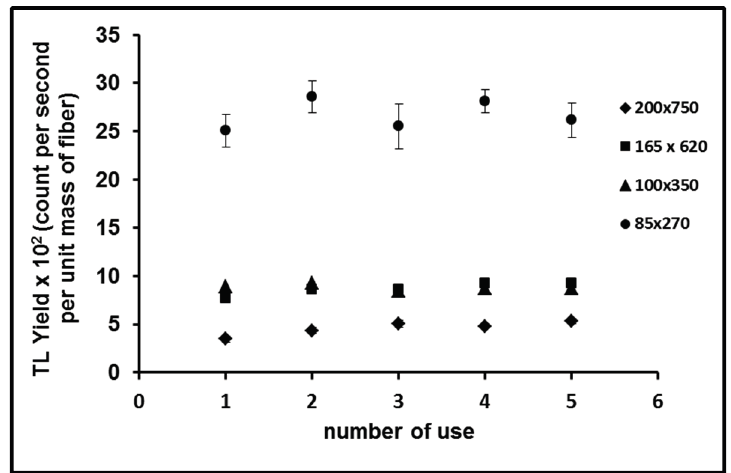
Figure 8. Reproducibility for the various Ge doped fibers exposed to doses of 10 Gy, provided together with the standard error of the